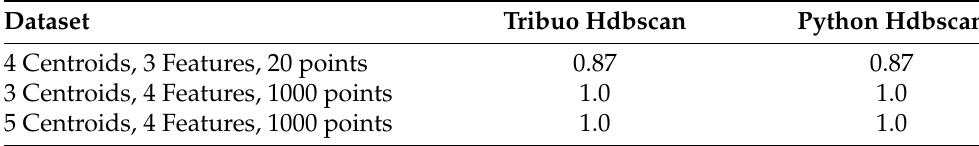
Table 4. The adjusted mutual information scores for the predicted cluster assignments.